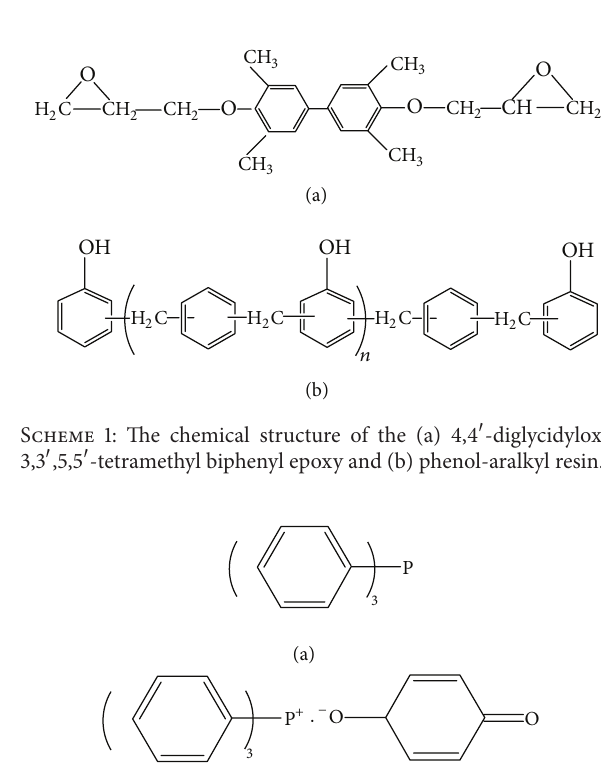
heated at a rate of 10 ∘ C/min from 0 ∘ C to 250 ∘ C. The